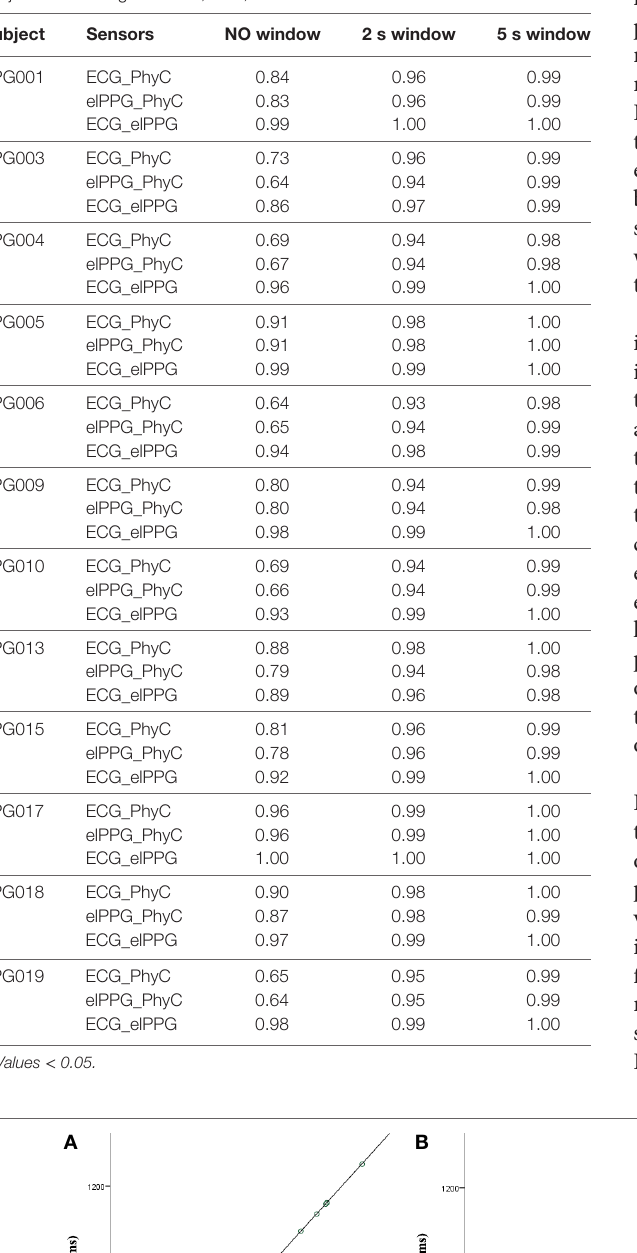
TaBle 4 | R 2 of the interbeat interval (IBI) linear regression between sensors by subject considering all the IBI, 2sW, and 5sW.